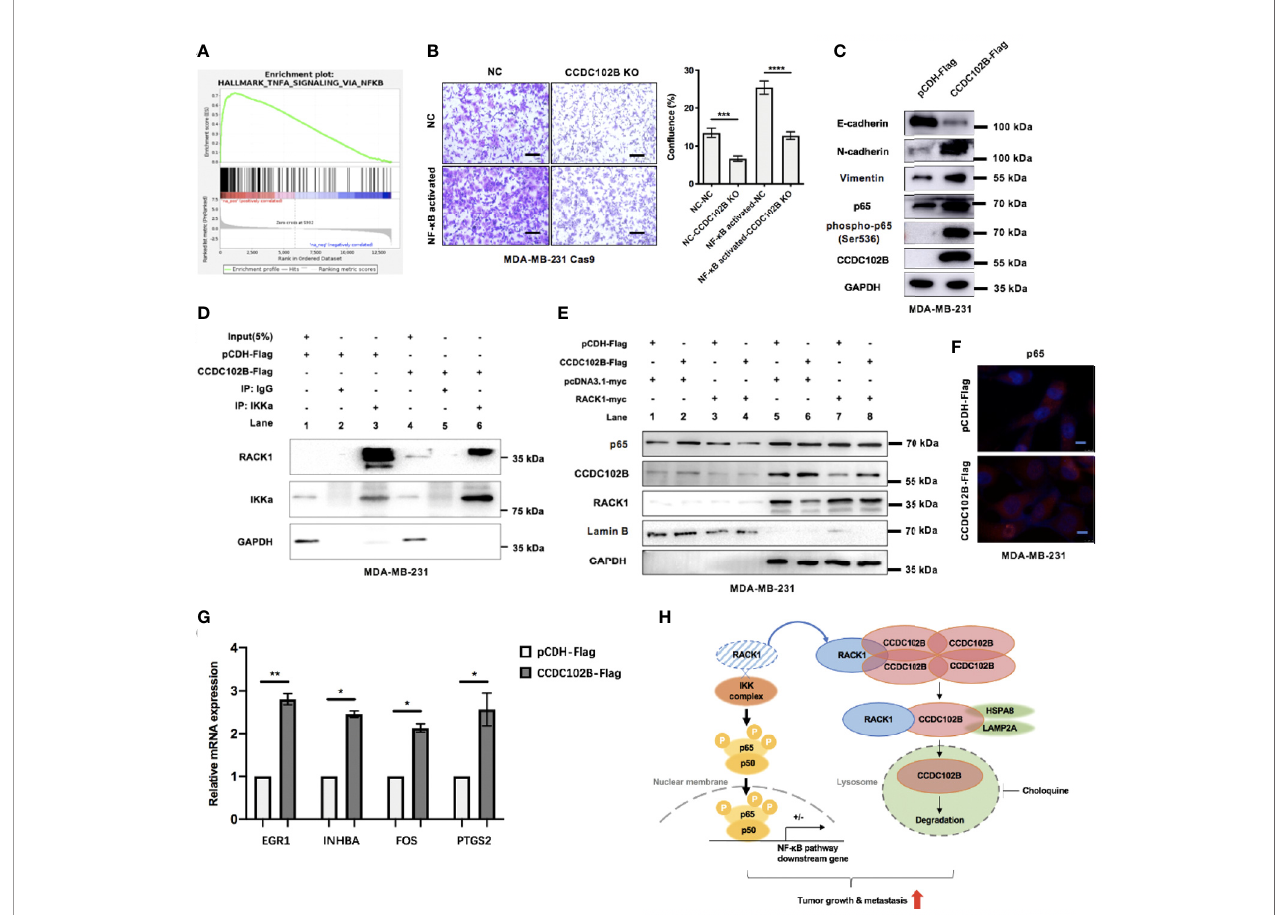
FIGURE 7 | CCDC102B activates NF − k B pathway by interacting with RACK1. (A) GSEA showed CCDC102B was signi fi cantly associated with NF − k B pathway. (B) Cell functional rescue tests with Transwell assay in MDA-MB-231 Cas9 cells. CCDC102B KO cells, NF − k B activated cells and the corresponding control cells were used. Representative photos and quantitative analysis were shown. Con fl uence of Transwell was analyzed by ImageJ. n=3, biological replicates. Scale bars: 100 m m. (C) Overexpressed CCDC102B was associated with increased p65, phospho-p65 (Ser536) and EMT in MDA-MB-231. (D) Overexpressed CCDC102B led to less interaction between RACK1 and IKK a . (E) Movement of p65 into cell nucleus was promoted by CCDC102B, which could be decreased by overexpressed RACK1. (F) Immuno fl uorescence showed movement of p65 into cell nucleus promoted by CCDC102B. Scale bars: 10 m m. (G) Expression of NF − k B pathway target genes in CCDC102B-overexpressing MDA-MB-231 cells measured by qRT-PCR. n=3, biological replicates. (H) Schematic diagram of CCDC102B regulating breast cancer metastasis via NF − k B pathway. *P ≤ 0.05; **P ≤ 0.01; ***P ≤ 0.001; ****P ≤